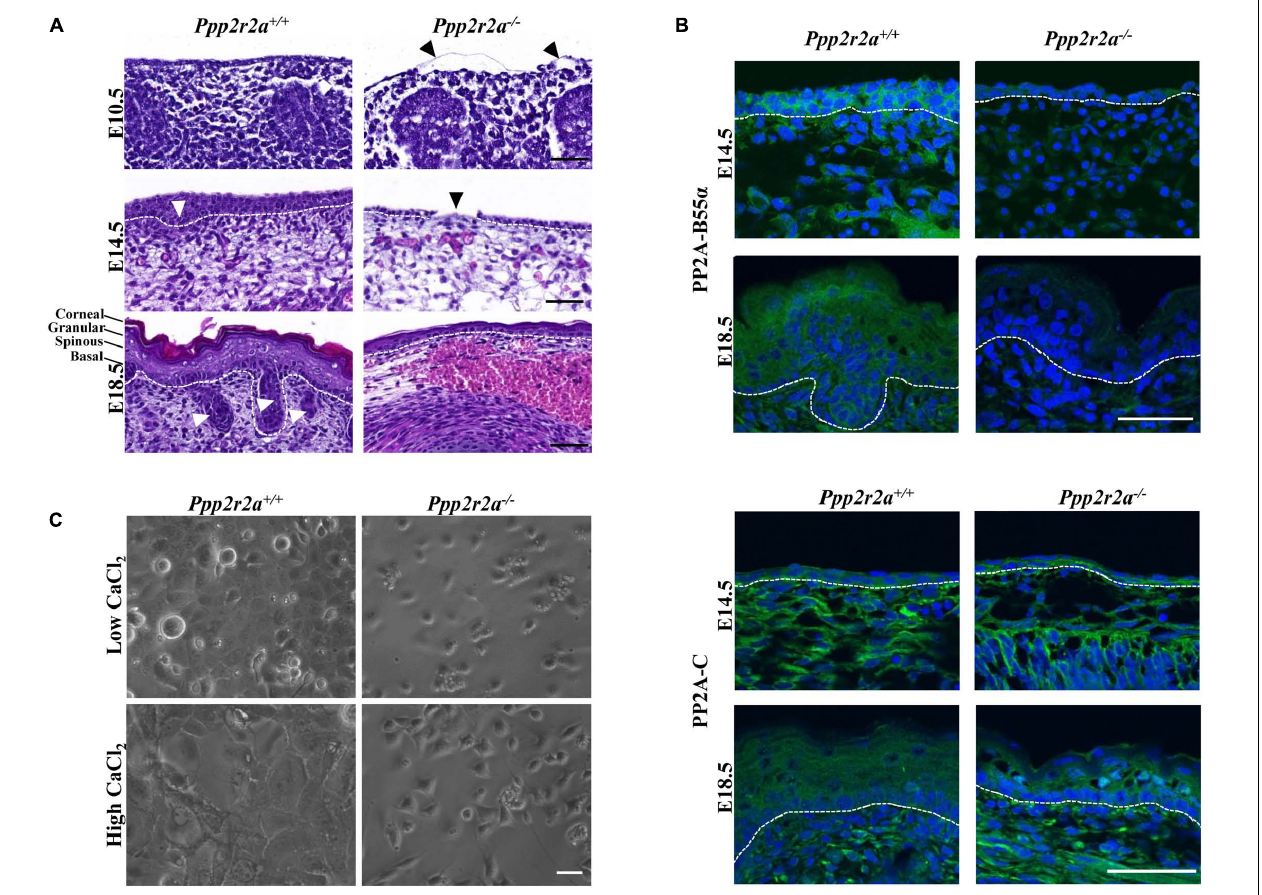
FIGURE 4 | Epidermal defect in late stage Ppp2r2a knockout embryos. (A) Representative H&E images of the epidermis of E10.5, E14.5 and E18.5 Ppp2r2a + / + and Ppp2r2a − / − mice. All three stages show thinner epidermal layers. E10.5 Ppp2r2a − / − embryos have regions of detached emerging epidermis (black arrowhead). Both E14.5 and E18.5 show subcutaneous hemorrhage and edema in the Ppp2r2a − / − embryos. Ppp2r2a + / + display emerging hair follicles at E14.5, and dermal appendages at E18.5 (white arrowhead), but these are absent in Ppp2r2a − / − embryos. At E14.5 the Ppp2r2a − / − embryos also showed regions of disrupted epidermis (black arrowhead). Dashed white line indicates dermal-epidermal junction. Scale bars = 50 µ m. (B) Representative immunofluorescence of PP2A-B55 α (green) and PP2A-C (green) in Ppp2r2a + / + and Ppp2r2a − / − epidermis at E14.5 and 18.5. Co-staining for DAPI is shown in blue. Dashed white line indicates the dermal-epidermal junction. Scale bars = 50 µ m. (C) Ppp2r2a + / + and Ppp2r2a − / − keratinocytes in low calcium and high calcium (post-48 h). Scale bar = 100 µ